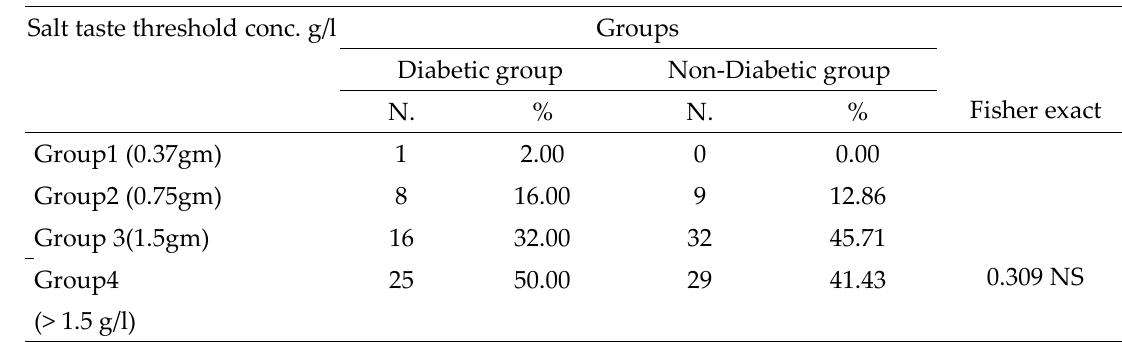
Table (3): Distribution of the sample with different salt taste thresholds among diabetic and non-diabetic groups Salt taste threshold conc. g/l